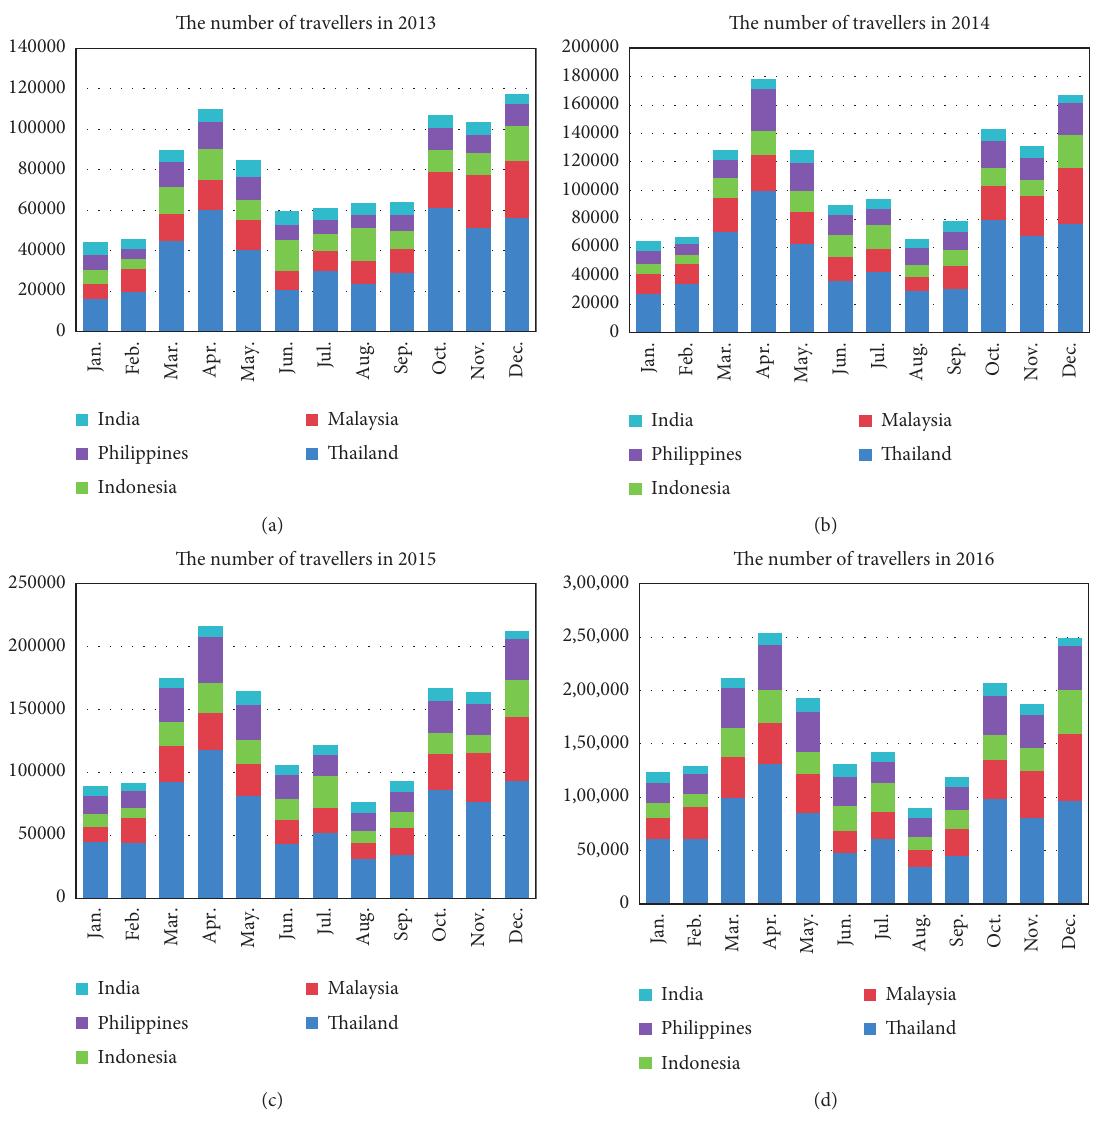
Figure 1: The distribution of